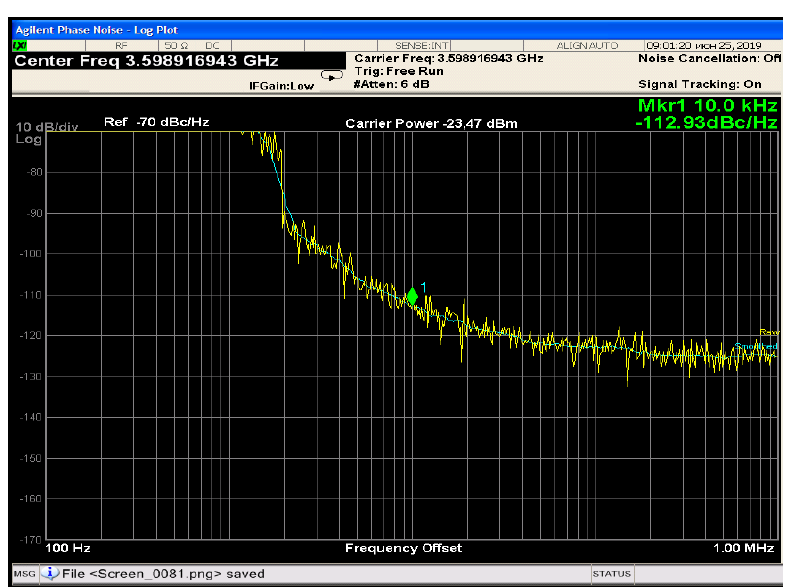
Fig. 6. VCO NSPD value at the offset of 10 kHz from the carrier 3.6 GHz with sampling.